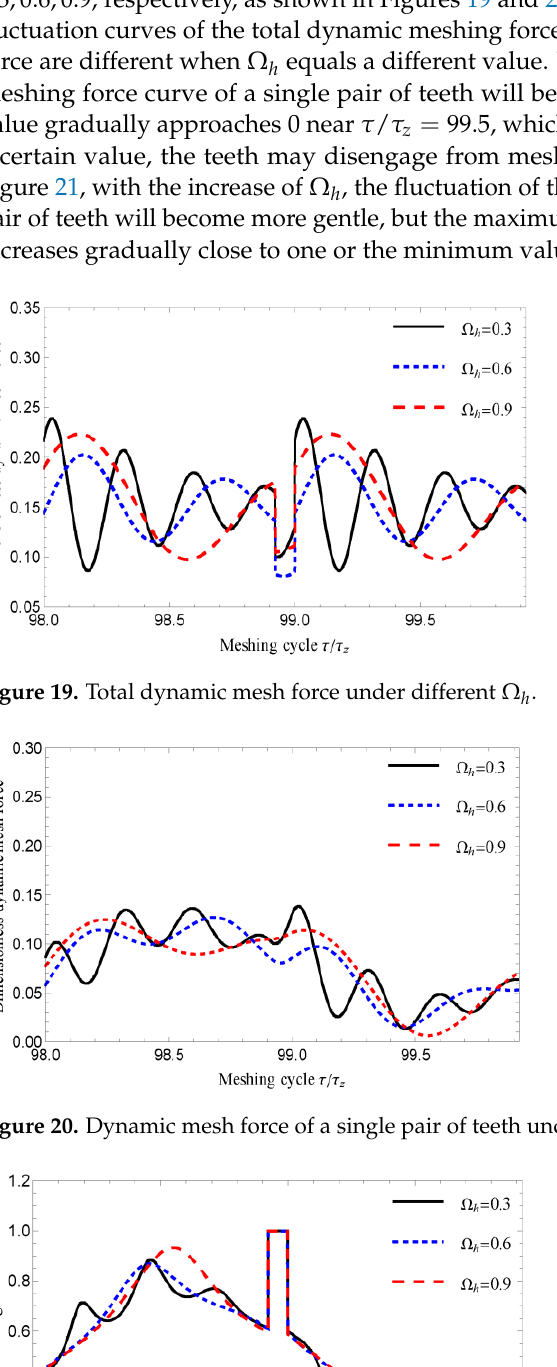
Figure 21. Load sharing ratio of a single pair of teeth under different 𝛺 ℎ .